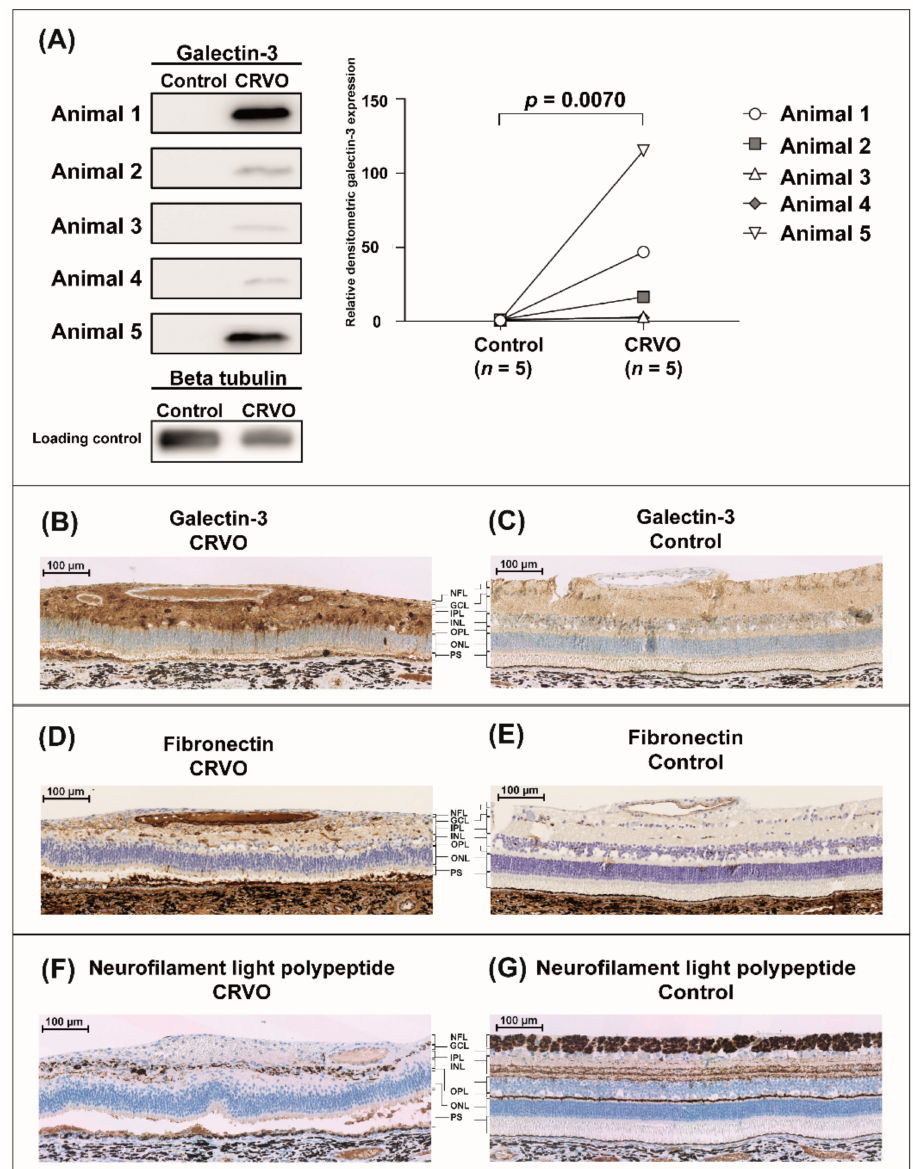
Figure 3. Reproducibility of the CRVO model at the molecular level. The reproducibility of the CRVO model was tested by confirming a number of key proteins that were previously found to be regulated in the model, including galectin-3, fibronectin and neurofilament light polypeptide. Laser-induced CRVO was compared to control eyes that received laser without inducing occlusion. Representative immunohistochemistry is provided. Additional immunochemistry from an additional animal is provided in the supplementary material (Figure S1). ( A ) Western blotting confirmed an upregulation of galectin-3 in the CRVO model. ( B , C ) Immunohistochemistry confirmed an upregulation of retinal galectin-3 in Müller glial cells in CRVO. ( D , E ) Immunohistochemistry confirmed an upregulation of fibronectin in the endothelium of retinal vessels and in proximity to the vessels. ( F , G ) Immunohis- tochemistry confirmed a downregulation of neurofilament light polypeptide indicating axonal loss in CRVO. Scale bar = 100 µ m. Reaction color: brown. Abbreviations: NFL: nerve fiber layer; GCL: ganglion cell layer; IPL: inner plexiform layer; INL: inner nuclear layer; OPL: outer plexiform layer; ONL: outer nuclear layer; PS: photoreceptor